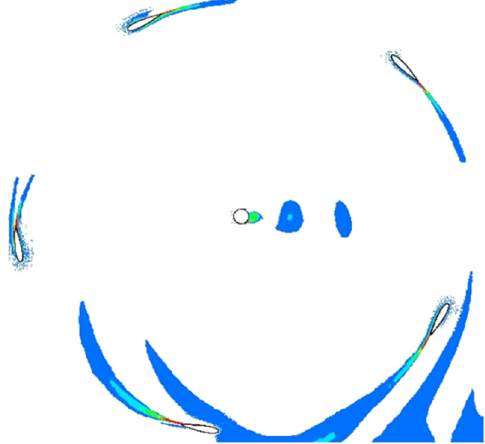
Figure 20. Vorticity profile obtained using CFD simulation of river inflow at 1.5 m/s and turbine rotation rate of 44 RPM.